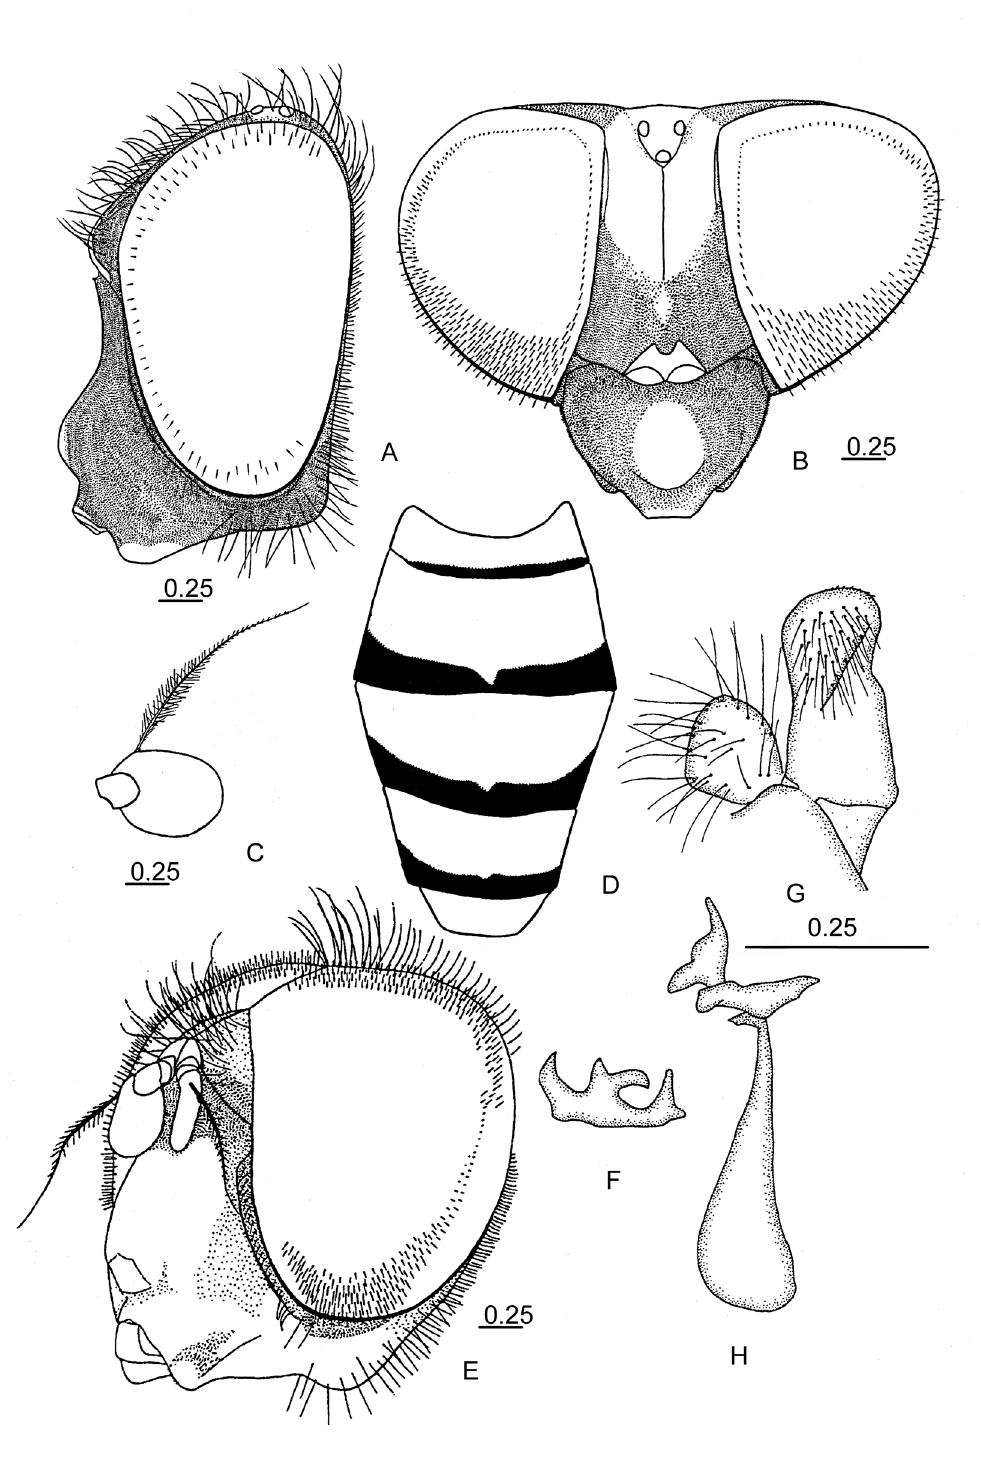
Fig. 17. Cheilosia ( Rubrocheila ) egregia Barkalov & Cheng, 1998. A . Head of ♀, lateral view. B . Head of ♀, dorsal view. C . Antenna of ♀, lateral view of pedicel and basoflagellomere. D . Abdomen of ♀, dorsal view. E . Head of ♂, anterior view. F . Superior lobe of hypandrium, lateral view. G . Surstylus and gonocercus, lateral view. H . Aedeagus and aedeagal apodeme, lateral view. After Barkalov & Cheng 2004. Scale bars indicated in